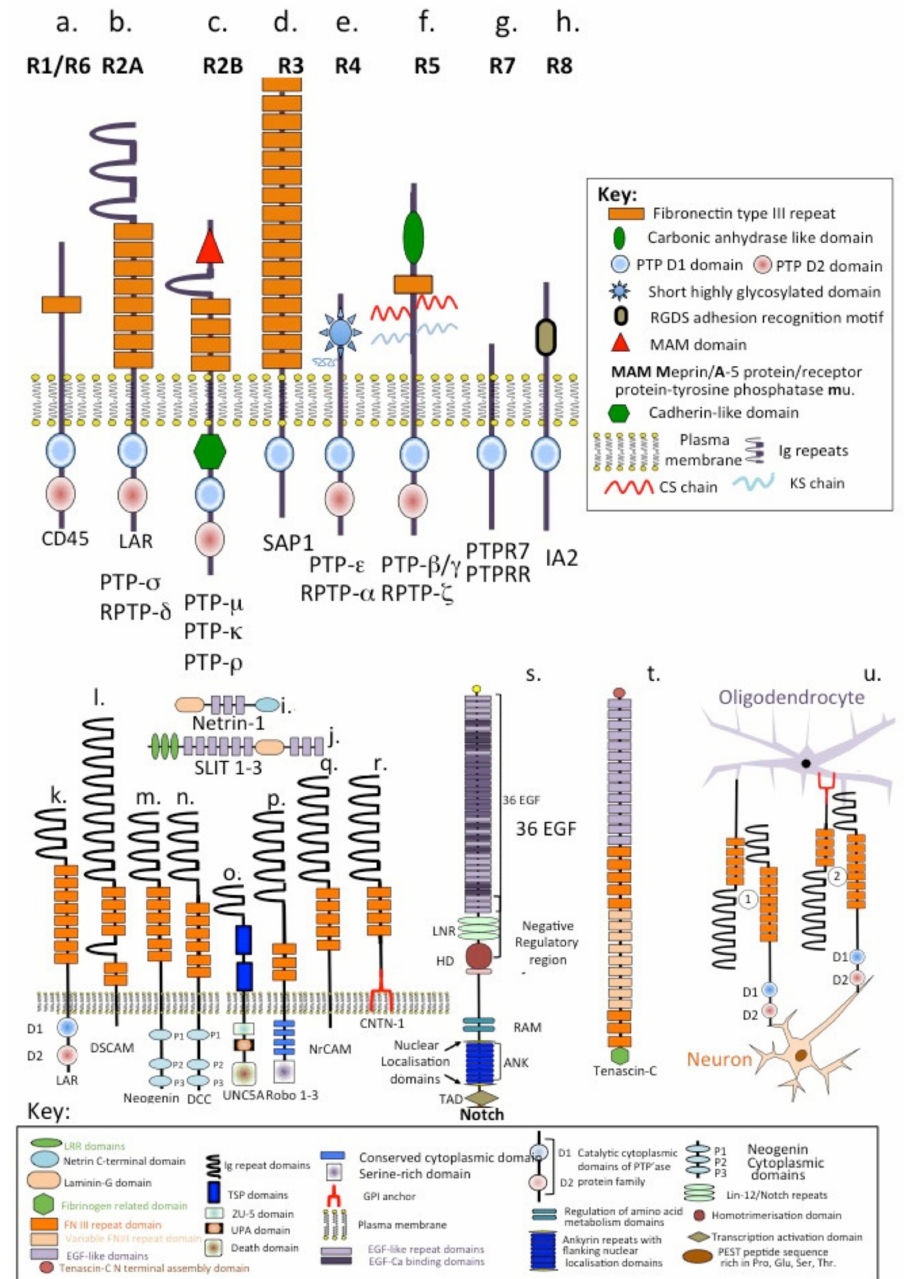
Figure 1. Schematic depictions of the structural organisation of the eight families of receptor protein tyrosine phosphatases ( a – h ) compared to neural cell adhesion molecules, neuroregulatory pro- teins and neural receptors, ( i – r ) Notch ( s ) and tenascin-C ( t ), and depiction of how interactions between receptor protein tyrosine phosphatases and neural cell adhesion molecules can facilitate oligodendrocyte–neuronal communication ( u